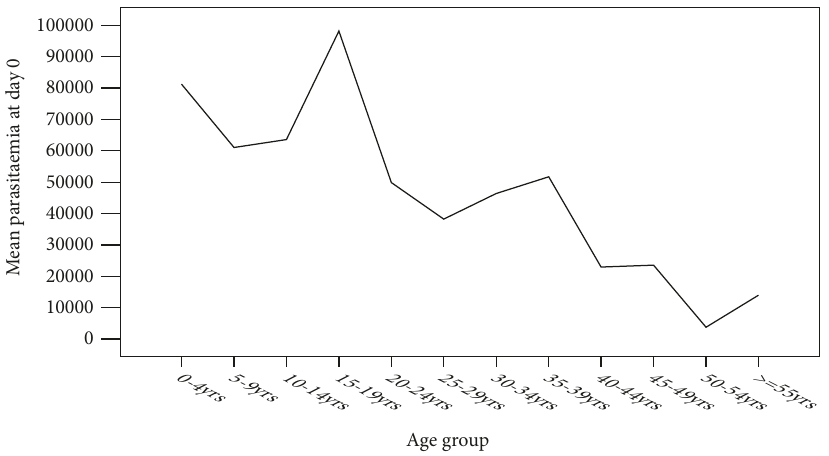
Figure 2: Mean parasite density in different age groups on day 0.